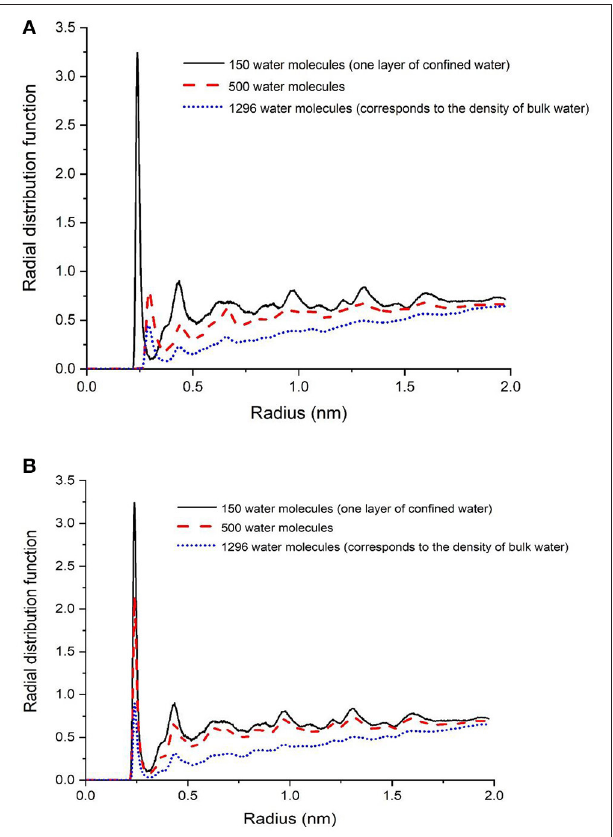
FIGURE 6 | Radial distribution function of calcium in calcite with respect to oxygen in water in systems composed of a single water layer, 500